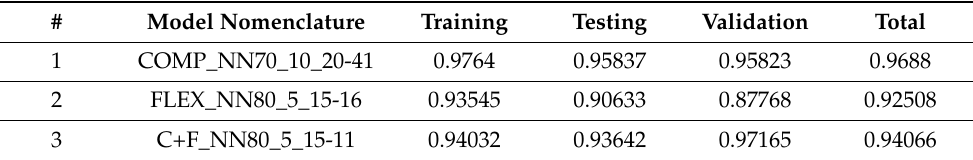
Table 8. Regression coefficients of the models with best